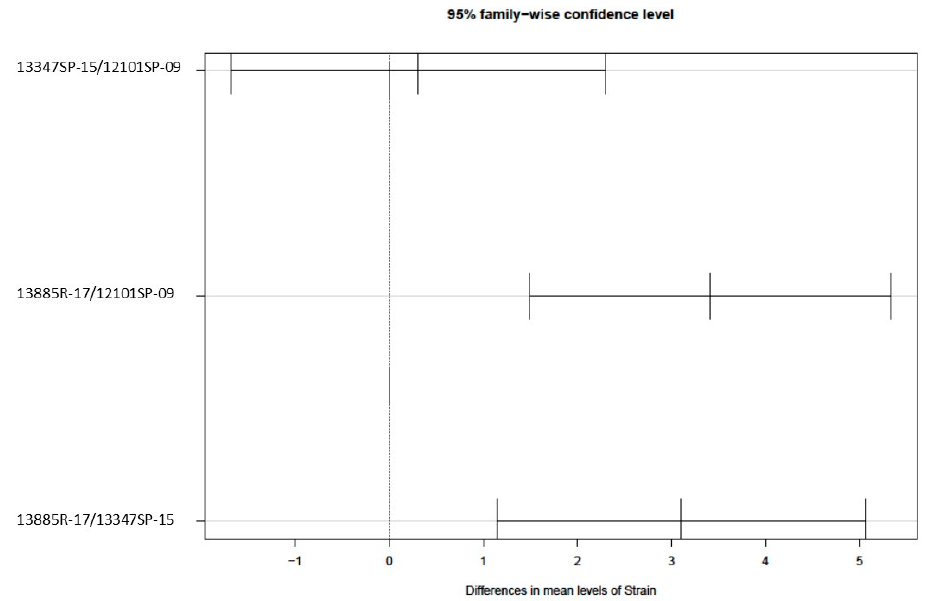
Figure 3. Results of Tukey’s multiple comparison test ( p -value = 0.05). Intervals that do not overlap the dotted line indicate a significant difference between the Ct values of the RT-qPCR from different challenge strains.